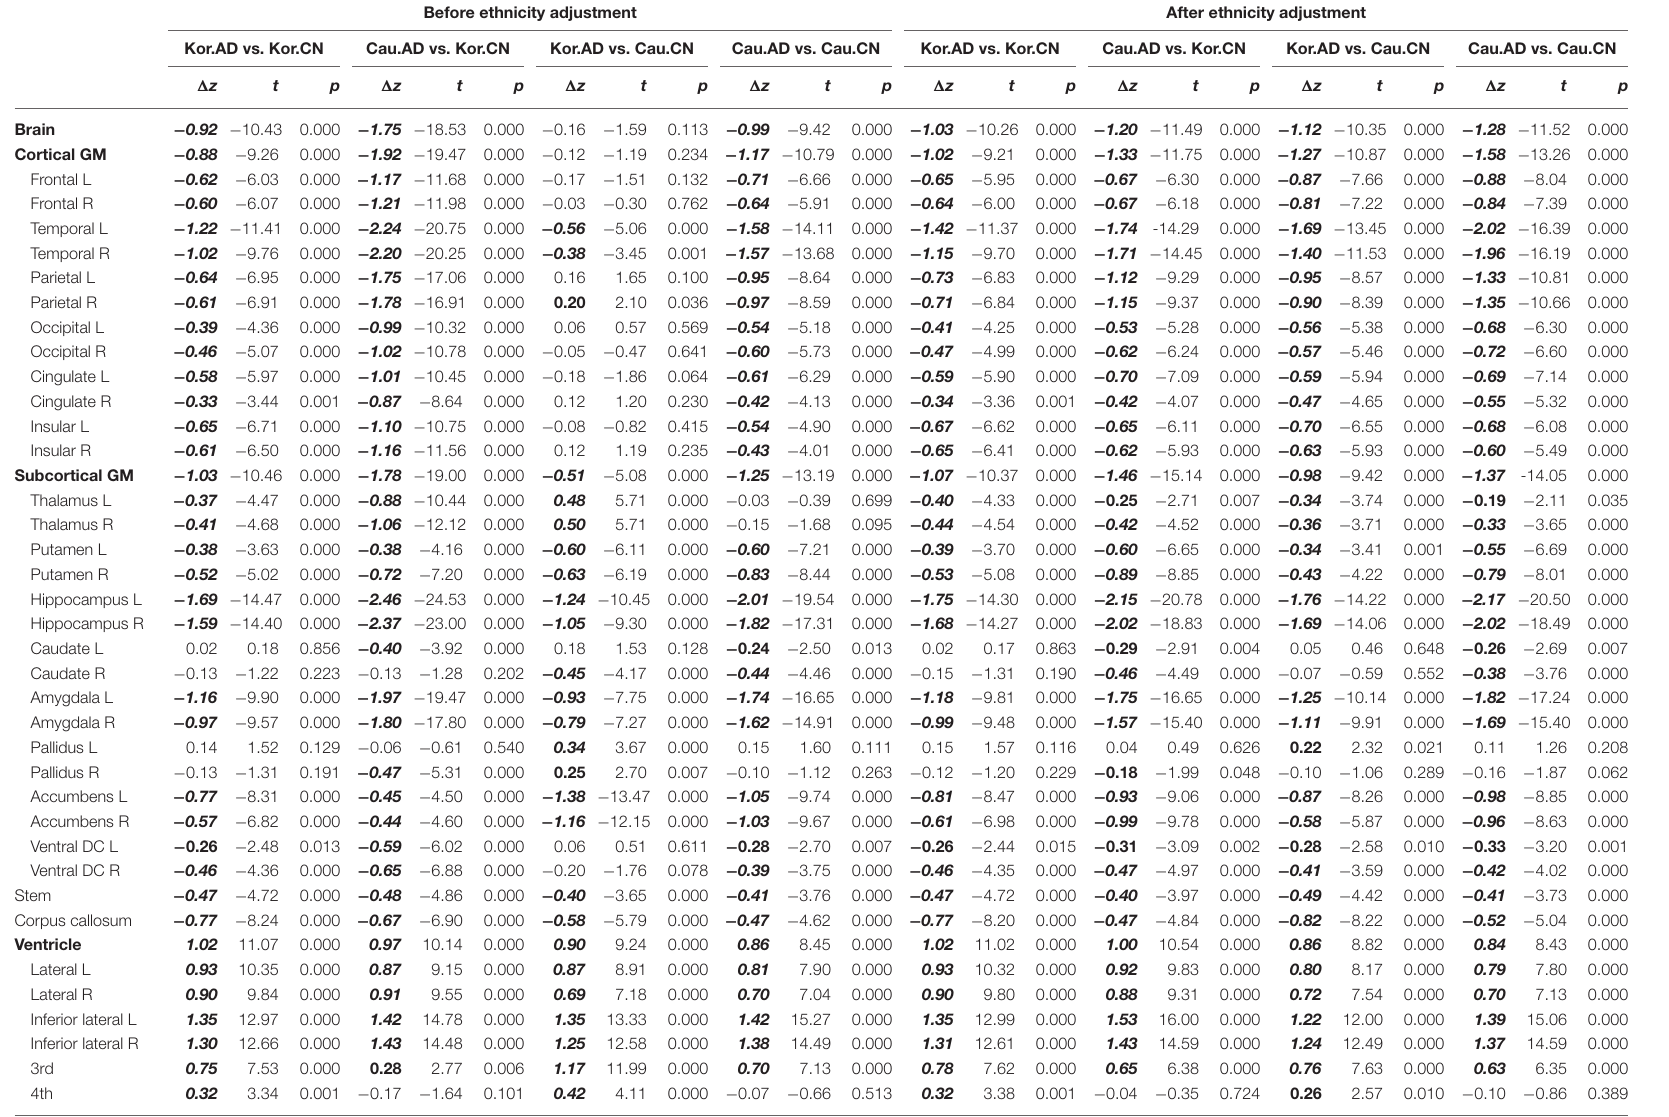
TABLE 6 | Z-score differences between AD patients and controls before/after ethnicity adjustment. Before ethnicity